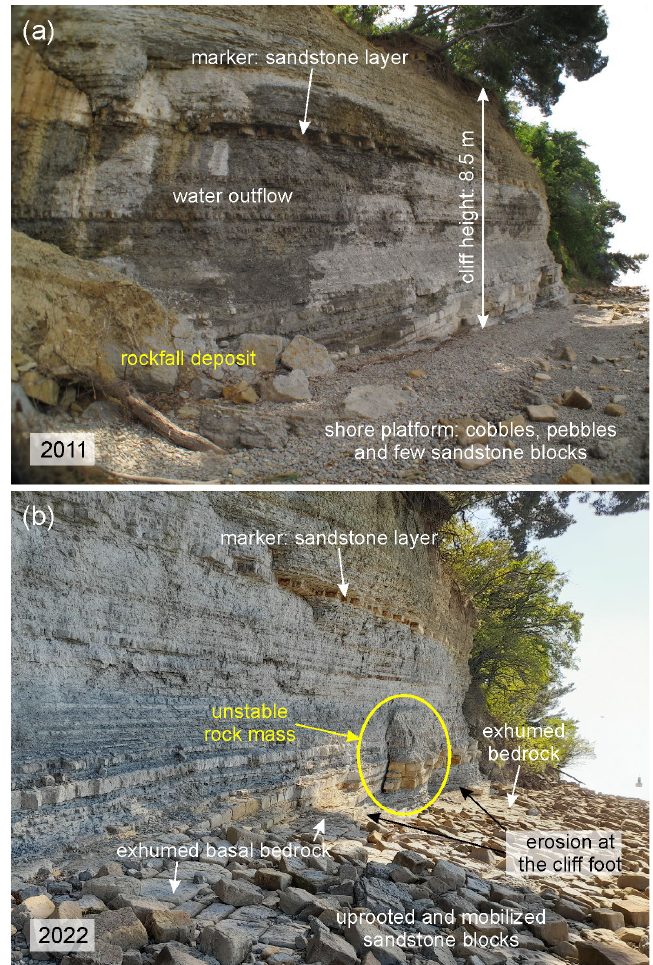
Figure 15. Stretch of the Flysch Sea cliff at Debeli Rtič (Sector D) as photographed in ( a ) 2011 and ( b ) 2022. Note the morphological evolution of the shore platform and the cliff foot caused by the combined action of marine erosion and slope instability processes.